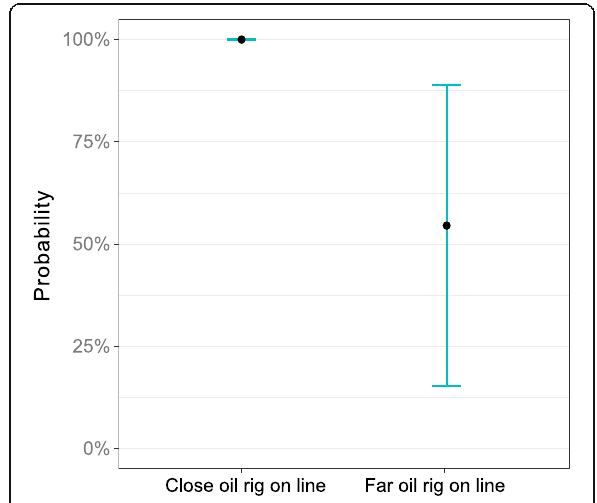
Fig. 10 Predicted probabilities of choosing the close oil rig to receive more damage. Bars represent 95% confidence intervals. Accurate interpretation would be to choose the close oil rig 100% of the